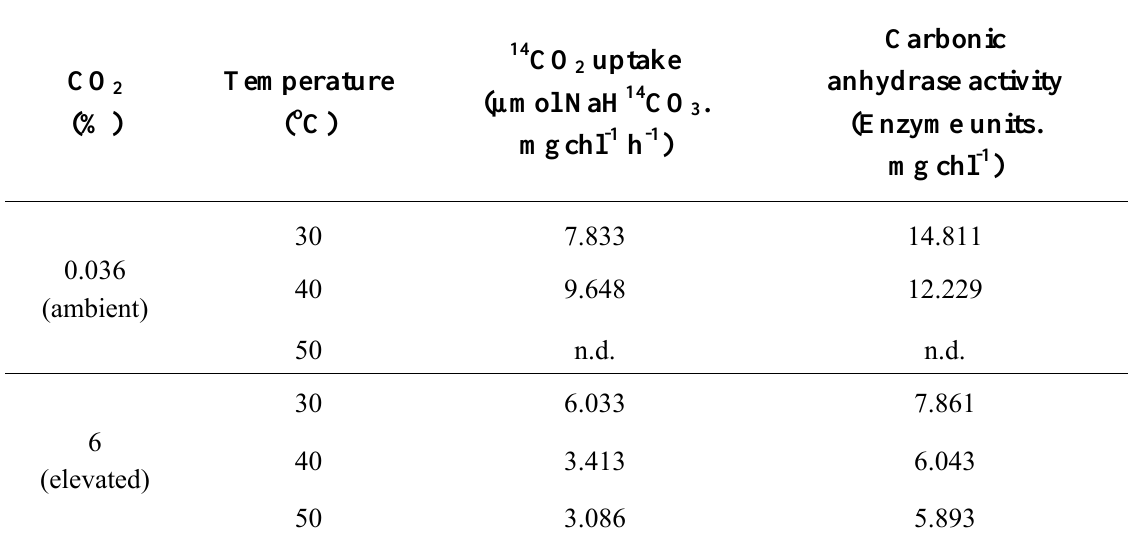
uptake and carbonic anhydrase activity of C. vulgaris under elevated CO Table 2. 14 CO 2 and temperature. C.D. at 5% level [CO and carbonic anhydrase activity is 0.340 and 0.520,